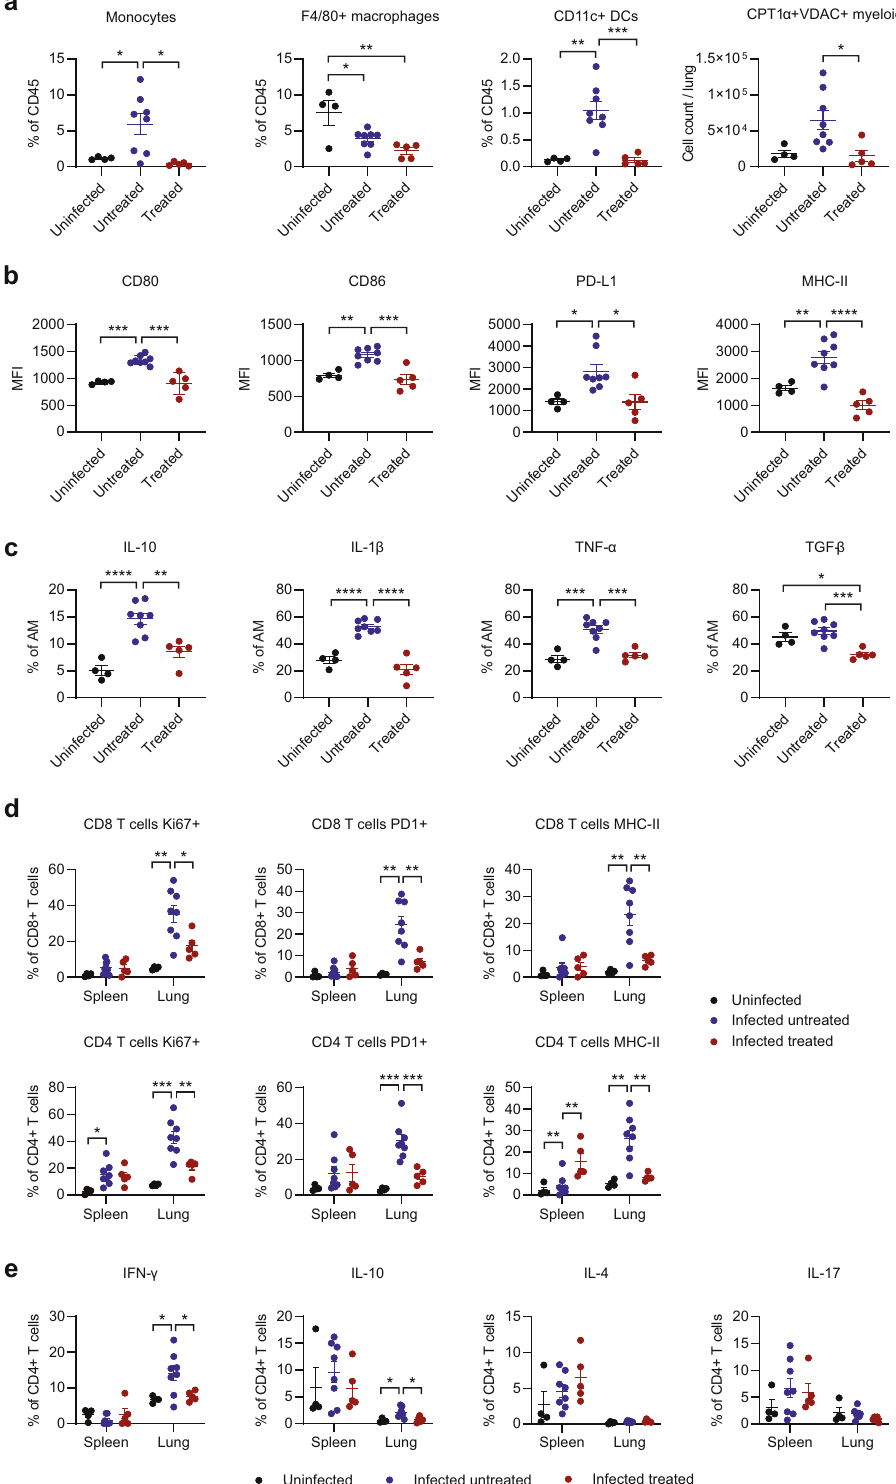
Fig. 5 Functional characterization of the immune response after SFN treatment. a Myeloid cell subsets shown as percent of total CD45 + immune cells within the lung. b Alveolar macrophages (AM) after stimulation with protein transport inhibitors. MFI, mean fl uorescent intensity. c Cytokine expression in alveolar macrophages after stimulation with protein transport inhibitors. d T cells were stained ex vivo immediately without further stimulation and evaluated for the expression of Ki67, PD1, and MHC-II. Percent of CD8 + or CD4 + T cells from spleen or lung expressing indicated marker are shown. e Percent of CD8 + or CD4 + T cells from spleen or lung expressing indicated marker after stimulation with PMA/ionomycin. Each dot represents one mouse. Data from one independent experiment, uninfected ( n = 4), infected untreated ( n = 8), infected treated ( n = 5). Data represented as mean ± standard error of mean. Statistical comparisons were made with one-way ANOVA, * P < 0.05, ** P < 0.01, *** P < 0.001, **** P < 0.0001.